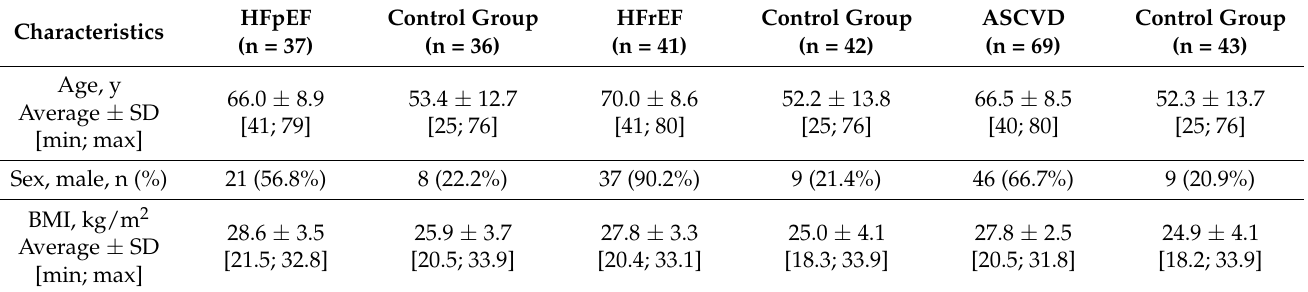
Table 2. Baseline characteristics of patients for MALDI-TOF-MS